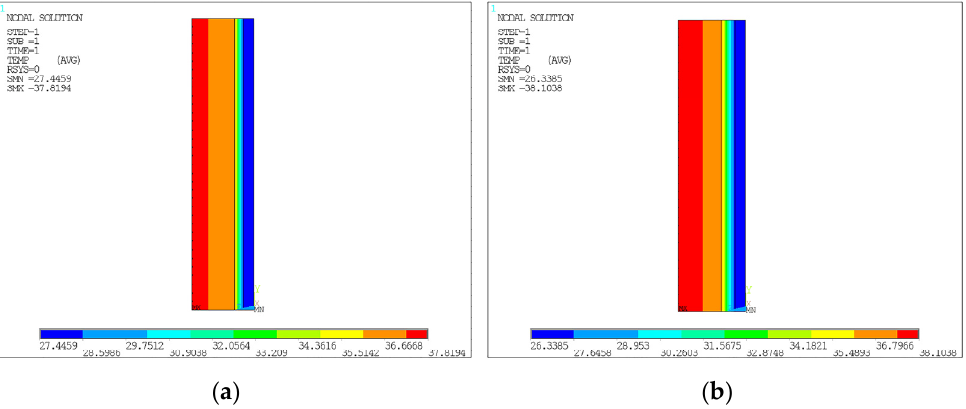
Figure 13. Temperature contour: ( a ) S-50XPS; ( b ) S-80XPS. Note: MX, MN are abbreviations for maximum and minimum, respectively; X, Y, and Z are the directions of the coordinates.